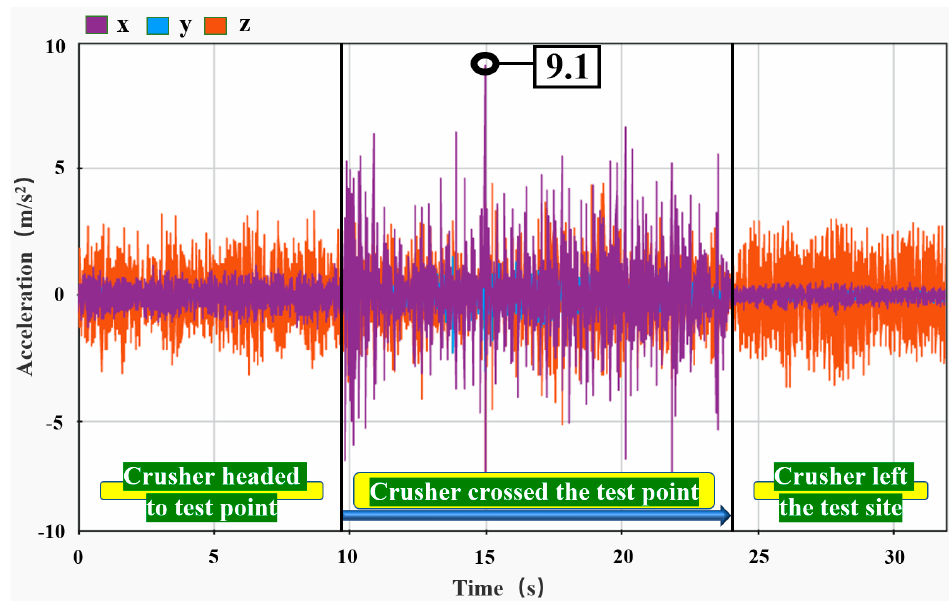
Figure 12. Results of the no-load test for the moving support rod.